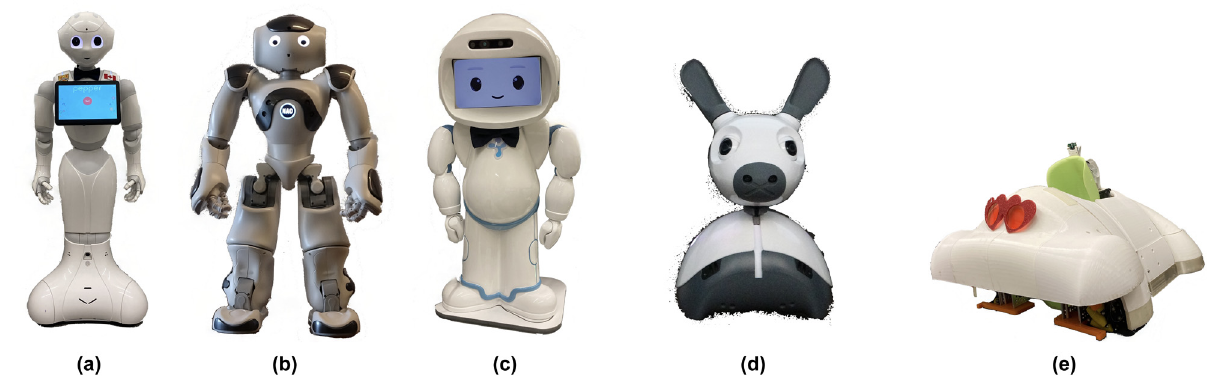
Figure 3: ( a ) Pepper ( Softbanks Robotics, Paris, France ) , ( b ) Nao ( Softbanks Robotics, Paris, France ) , ( c ) QT ( LuxAI, Luxembourg, Luxembourg ) , ( d ) Miro ( Consequential Robotics, She ffi eld, UK ) , ( e ) MyJay ( University of Waterloo, Waterloo, Canada )